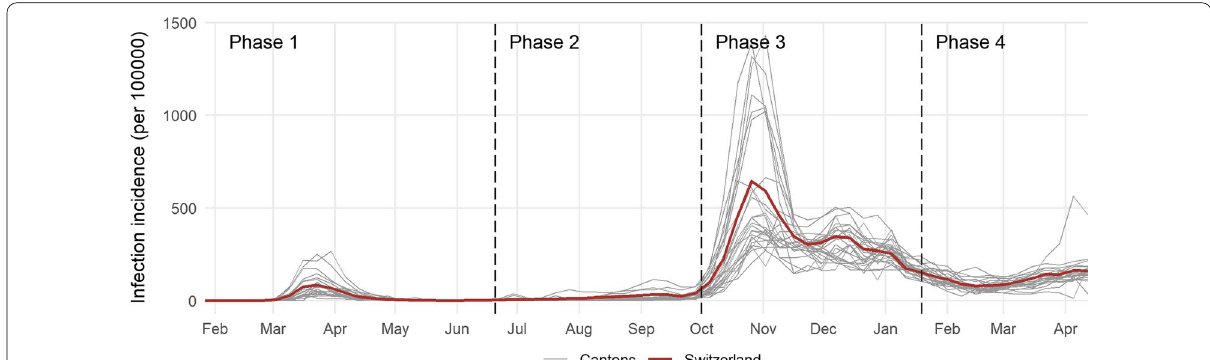
Fig. 1 Weekly infection incidence. The weekly infection incidence reflects the number of confirmed cases per 100,000 residents during the respective week. The number of confirmed cases is provided by OpenZH (https:// github. com/ openZH/ covid_